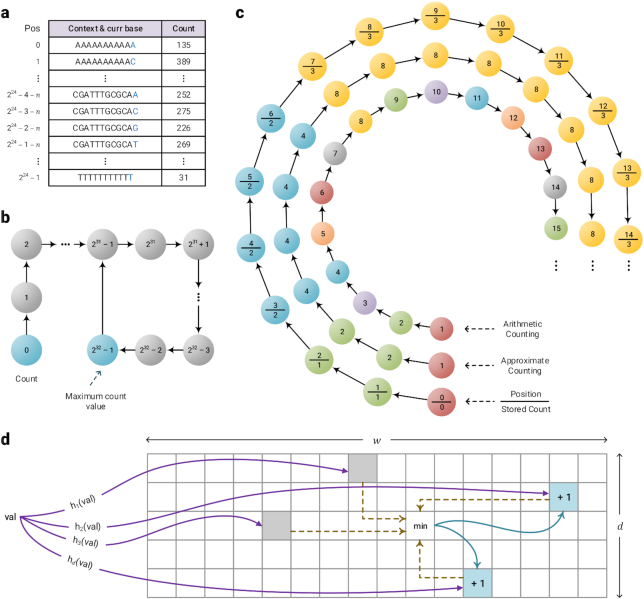
The data structures used by Smash++ to store the models in memory. (a) Table of 64-bit counters that uses up to 128 MB of memory, (b) table of 32 bit counters that consumes at most 960 MB of memory, (c) table of 8 bit approximate counters with memory usage of up to 1 GB, and (d) Count-Min-Log sketch of 4-bit counters, which consumes up to \documentclass[12pt]{minimal}
\usepackage{amsmath}
\usepackage{wasysym}
\usepackage{amsfonts}
\usepackage{amssymb}
\usepackage{amsbsy}
\usepackage{upgreek}
\usepackage{mathrsfs}
\setlength{\oddsidemargin}{-69pt}
\begin{document}
}{}$\frac{1}{2} w\times d$\end{document} B of memory; e.g., if w = 230 and d = 4, it uses 2 GB of memory.